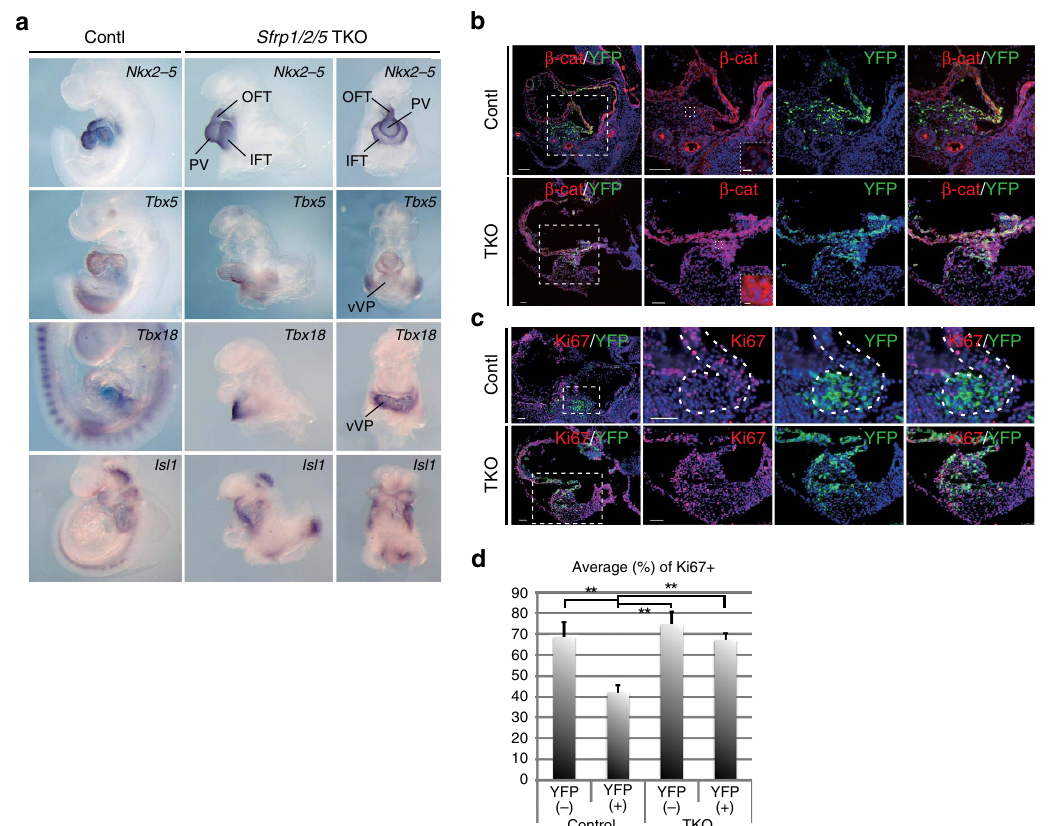
Figure 4 | Sfrp1/2/5 TKO embryos exhibit hyperplasia of the IFT accompanied by activated canonical Wnt signalling. ( a ) ISH of control and TKO embryos with probes for Nkx2-5 , Tbx5 , Tbx18 and Isl1 genes. PV: primitive ventricle. ( b , c ) Double immunohistochemistry using anti- b -catenin ( b ) or anti-Ki67 ( c ) antibodies in control and TKO embryos. Rectangles from the left end panels are magnified in the right panels. Further magnified photos, located in the right bottom window, show that b -catenin accumulated in YFP-expressing cells in the ventral venous pole in TKO embryos. ( d ) Percentage of Ki67 positive ( þ ) cells in Sfrp5 - YFP -expressing ( þ ) or negative ( (cid:2) ) cells in control and TKO embryos ( n ¼ 3). Data are presented as mean ± s.d.; ** P o 0.01, as compared with control samples. Scale bars ¼ 50 m m (5 m m in dotted